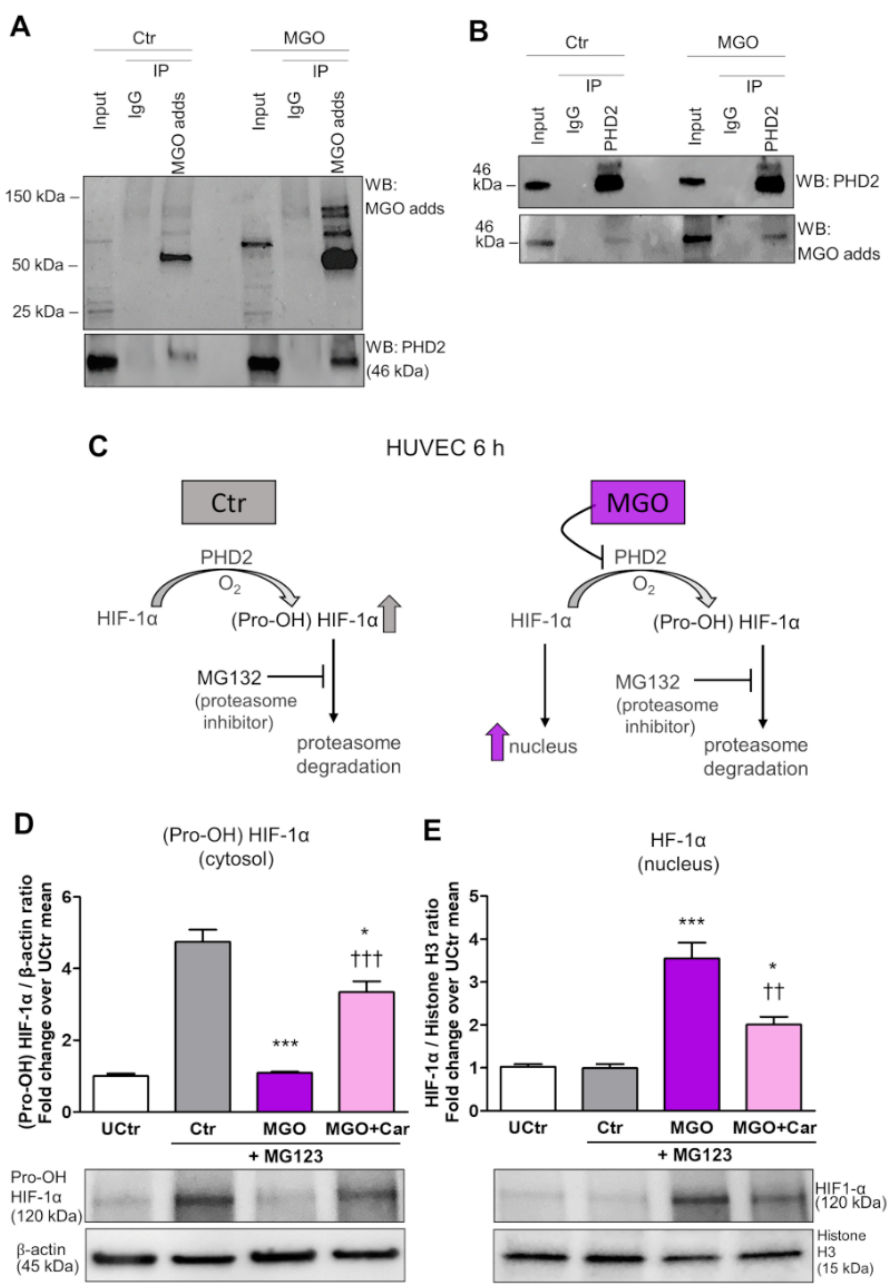
Figure 4. The glycolytic side-product MGO activates nuclear translocation of HIF-1 α by inducing post-translational glycation and inhibition of PHD2 activity. IP of MGO-protein adducts (MGO adds) ( A ) or PHD2 ( B ) on HUVEC treated (MGO) or not (Ctr) with 200 µ M MGO for 6 h, using a specific antibody for MGO modified proteins ( A ) or a specific anti-PHD2 antibody ( B ), respectively. Mouse IgG were used as control. Total cell lysates (Input) and immunoprecipitates were immunoblotted for PHD2 and MGO protein adducts ( A , B ). In the presence of oxygen, HIF-1 α is rapidly hydroxylated by PHD2 to generate (Pro-OH) HIF-1 α , which is degraded through the ubiquitin-proteasome pathway; proteasome inhibition with MG132 led to Pro-OH HIF-1 α increase, and adding MGO prevented (Pro-OH) HIF-1 α increase and led to HIF-1 α nuclear translocation ( C ). Western blot analysis for (Pro-OH) HIF-1 α in total extracts ( D ), and non-hydroxylated HIF-1 α in nuclear extracts ( E ) from HUVEC, treated or untreated (UCtr) with the proteasome inhibitor MG132 (10 µ M) for 6 h, with or without MGO, in the presence or absence of Car. Bars represent mean ± SEM. Post hoc multiple comparison: *** p < 0.001 or * p < 0.05 vs. Ctr; ††† p < 0.001 or †† p < 0.01 vs. MGO.